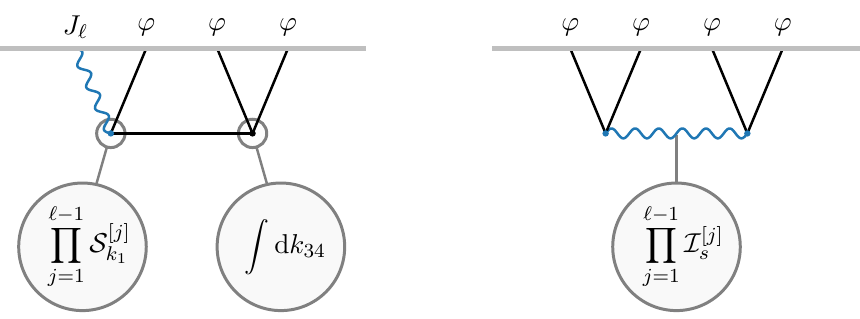
Figure 4. Illustration of the transmutation operators for h J ‘ ϕϕϕ i ( left ) and h ϕϕϕϕ i ( ‘ ) ( right